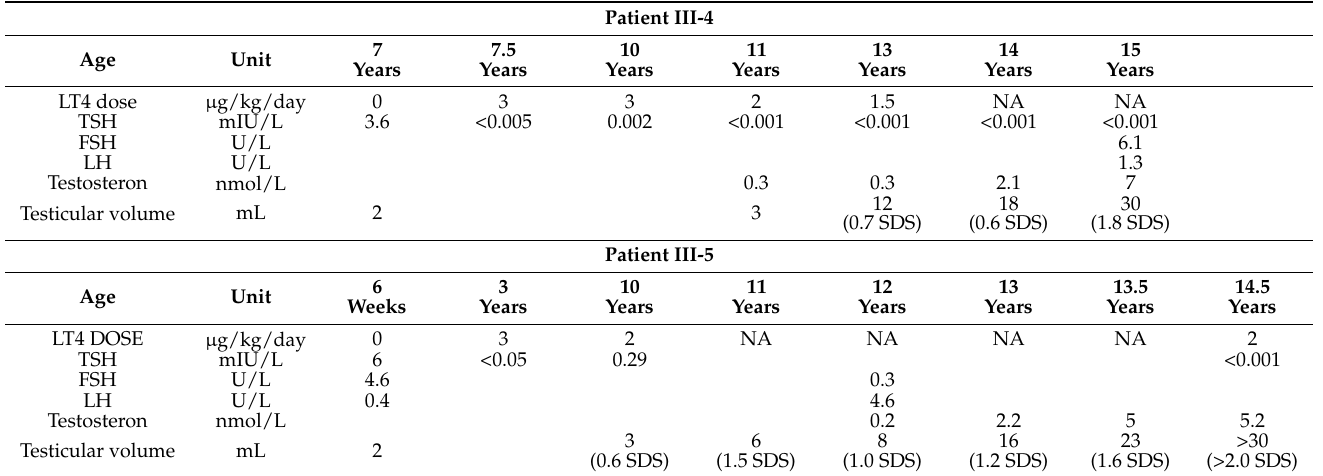
Figure 2. Family pedigree of the two brothers with the p.C947R variant showing affected and carrier family members. Numbers I, II and III indicate the first, second and third generation. Closed figures = hemizygous p.C947R variant; half open figures = carrier. Table 3. Longitudinal data on testicular volume, FSH, LH and testosterone levels of the two brothers with a p.C947R variant. Testicular volume according to Tanner, standard deviation score is indicated between brackets [21] .